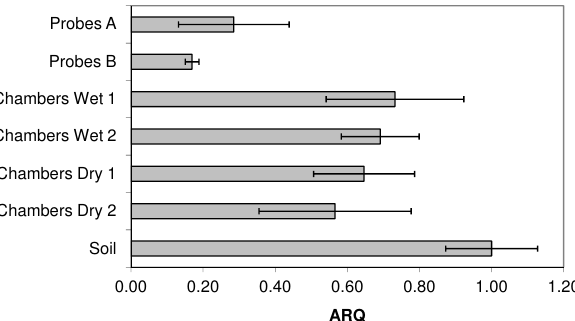
Fig. 3. The average ARQ for the gases sampled from in-stem probes, chamber headspace, and soil pore space, averaged over all trees. The error bars represent one standard deviation. The average for in-stem probes does not include tree “Marupa 3”, which gave a value of 0.88 in sampling period A and 0.77 in sampling period B (Table